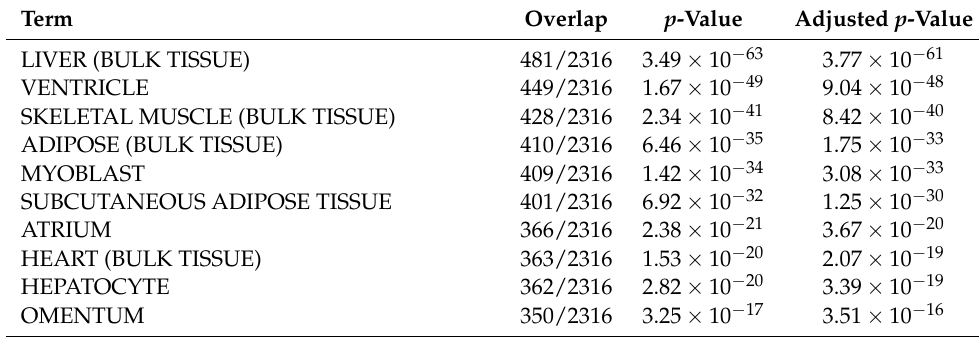
Table 2. Top 10 terms in the “ARCHS4 Tissues” category in Enrichr.